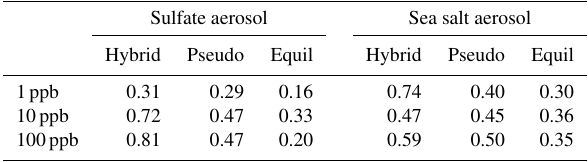
Table 3. Box-model computation time required by HyDiS-1.0, given as fraction of the computation time used by the GLOMAP aerosol microphysical